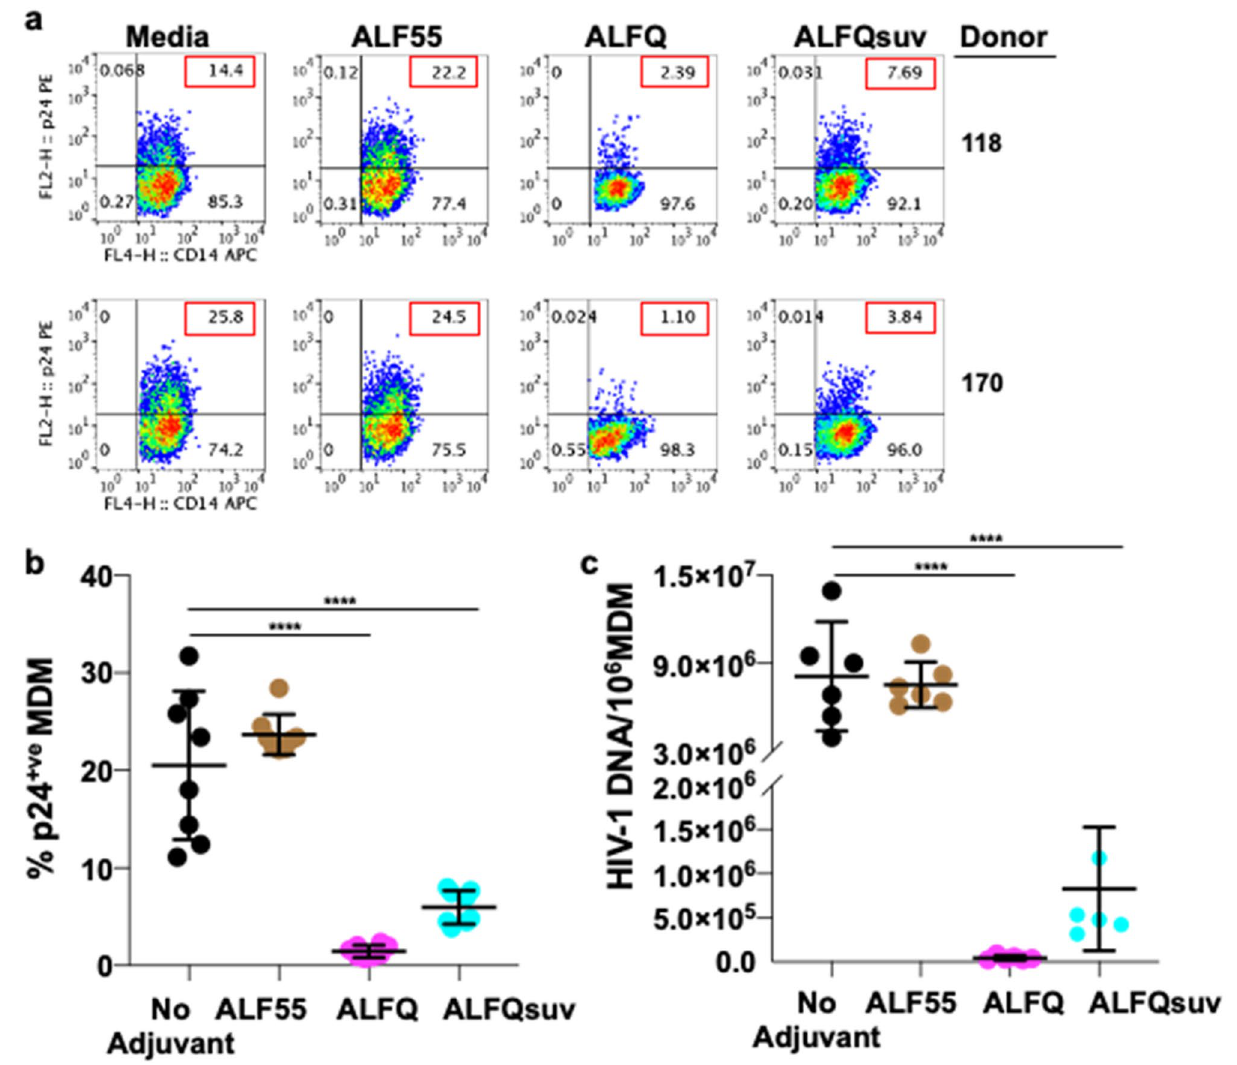
Figure 7. Large liposomes principally mediate restriction of HIV-1 infection in ALFQ-treated MDM. Primary human monocytes were differentiated into MDM following in vitro culture with M-CSF media. At day 4 post- culture, the cells were treated with ALF55, ALFQ, or ALFQsuv for 24 h. Untreated MDM (no adjuvant) cultures served as controls. Cells were washed and infected with US-1 (4 ng p24). Cultures were harvested at day 5 post- infection (p.i) and analyzed for the presence of intracellular p24 by flow cytometry and HIV-1 DNA content by qPCR. ( a ) Values (red boxes) in the upper right quadrant(s) of the flow plots represent the percentage of HIV- 1-infected MDM under each treatment. ( b ) Scatter dot plots represent the data from quadruplicate wells of two donors ( a ) and show the percentage of HIV-1-infected MDM (mean ± s.d.) in untreated MDM (black circles), MDM treated with ALF55 (brown circles), ALFQ (magenta circles) or with ALFQsuv (cyan circles). ( c ) Scatter dot plots show the amount of HIV-1 per 10 6 HIV-1-infected MDM (mean ± s.d.) in untreated MDM (black circles), MDM treated with ALF55 (brown circles), ALFQ (magenta circles) or with ALFQsuv (cyan circles) from triplicate wells of the two donors. Statistical differences between the groups were determined by One-way ANOVA. **** P <